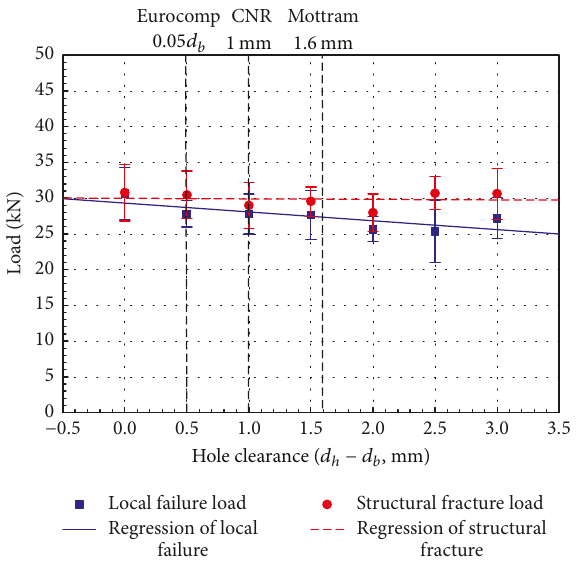
Figure 15: Relationship between load and bolt-hole clearance (specimen from